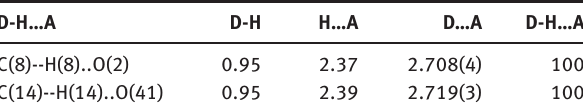
Table 3: Significant intermolecular interactions (interatomic distance (Å)) and bond angels.